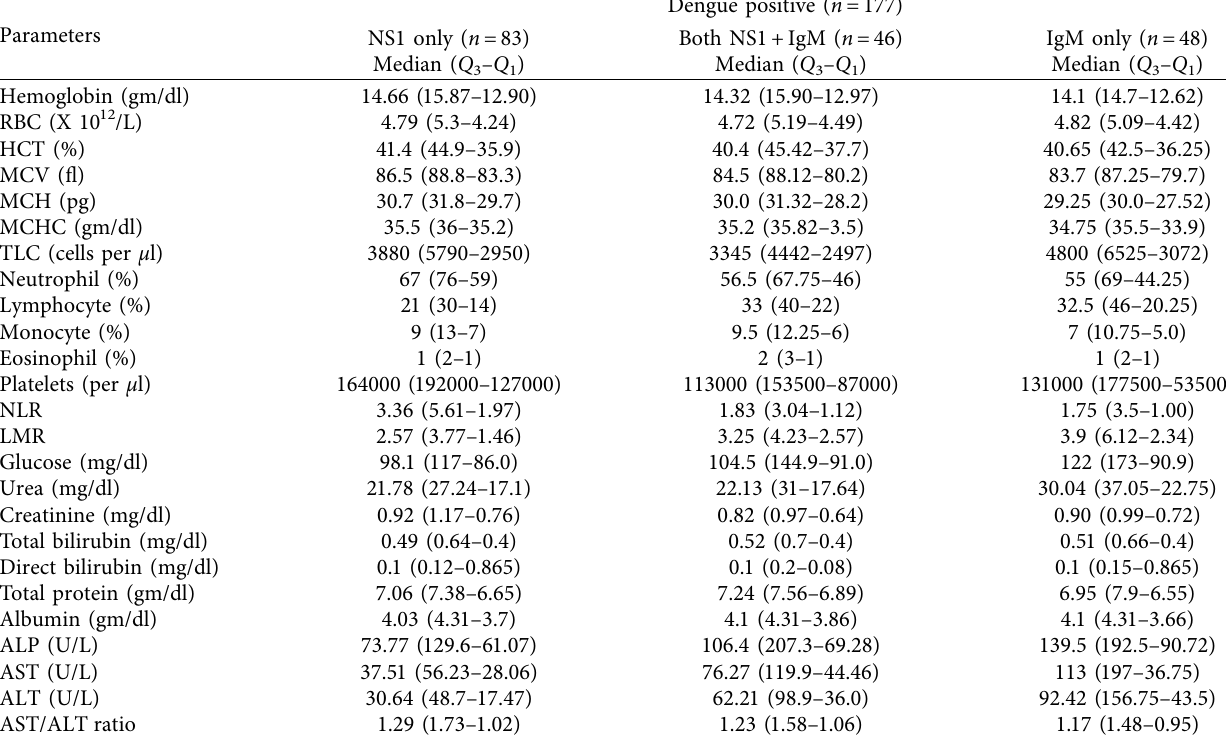
Table 2: Comparison of hematological and biochemical fndings in NS1, IgM, and NS1 +IgM positive dengue patients.